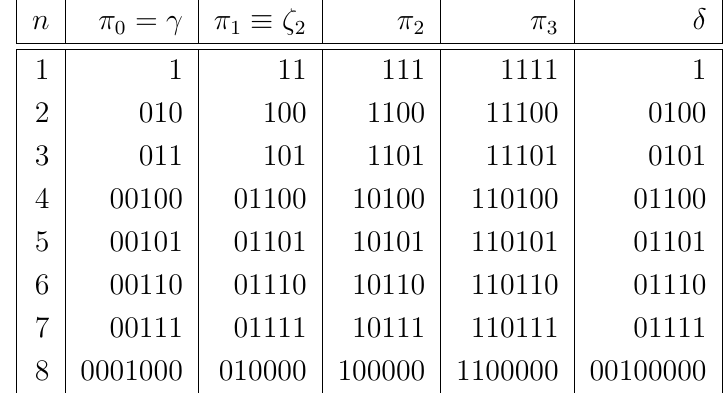
Table 6. The initial segment of π π ≡ ζ 1 2